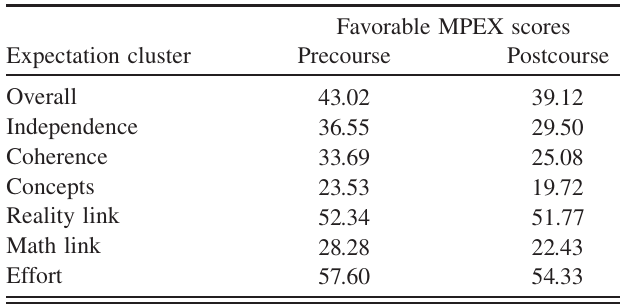
TABLE VIII. Students’ percentages of precourse and post- course favorable MPEX scores in